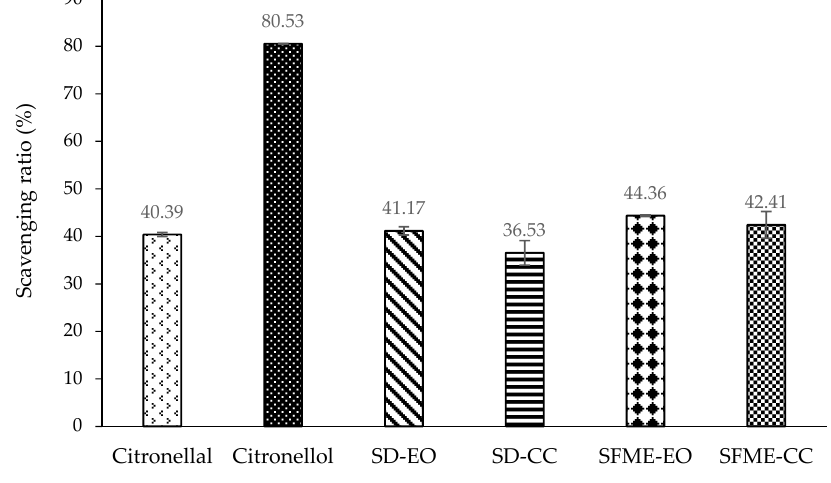
Figure 3. Nitric oxide (NO) radical scavenging ratio (%) of ‘Mato Peiyu’ leaf essential oils, citronellal, and citronellol. SD-EO, SFME-EO, citronellal, and citronellol were measured at a concentration of 0.250% ( v / v ). SD-CC and SFME-CC were measured at concentrations of 0.127% and 0.150% ( v / v ) according to the composition ratios in 0.250% ( v / v ) SD-EO and SFME-EO, respectively. Data are presented as the mean ± standard deviation based on triplicate determination.